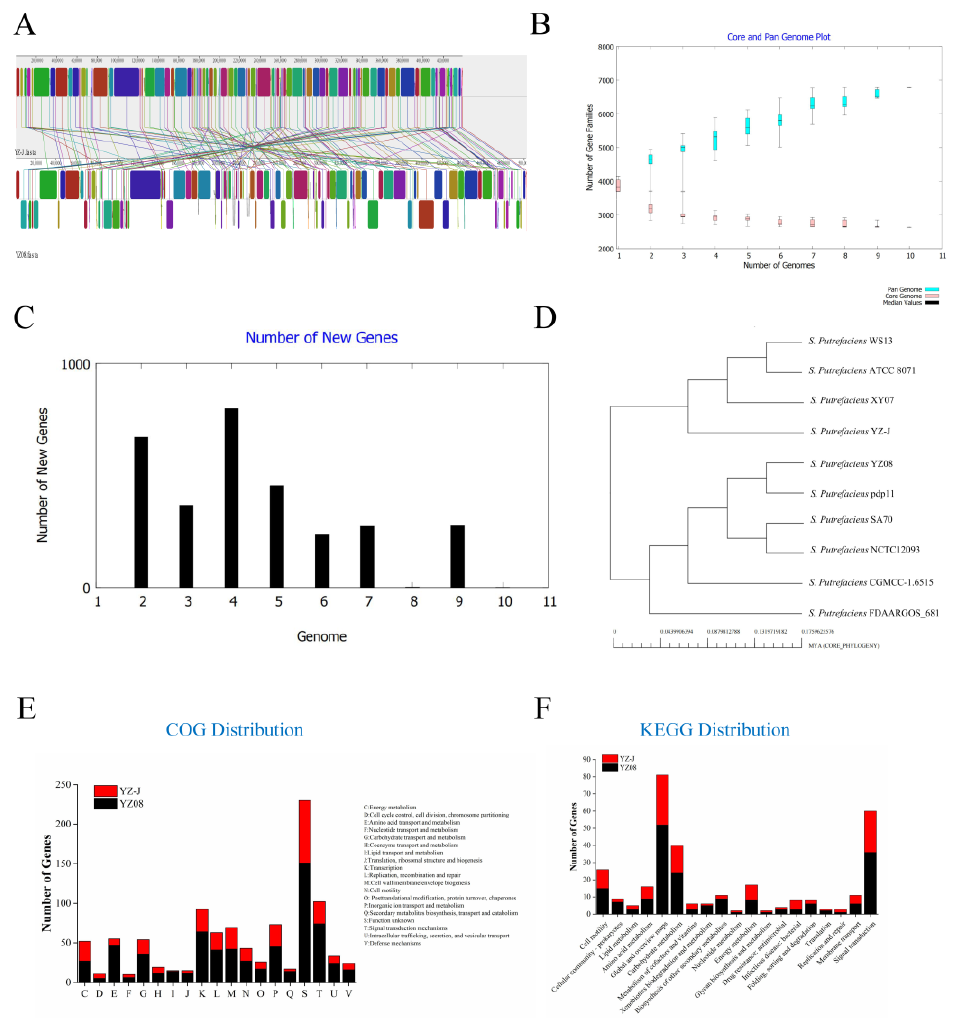
Figure 3. Genome synteny and pan-genome analysis of S.putrefaciens . ( A ) The mauve visualization of the whole genomes of S. putrefaciens YZ08 and YZ-J. The homologs distributed in these genomes are connected by lines; ( B ) pan-genome and core genome profile of different 10 S. putrefaciens strains; ( C ) prediction of increase in gene number when adding new genome; ( D ) phylogenetic tree based on pan genomes; ( E ) COG and ( F ) KEGG distribution of unique genes based on pan-genome of S. putrefaciens YZ08 and YZ-J.